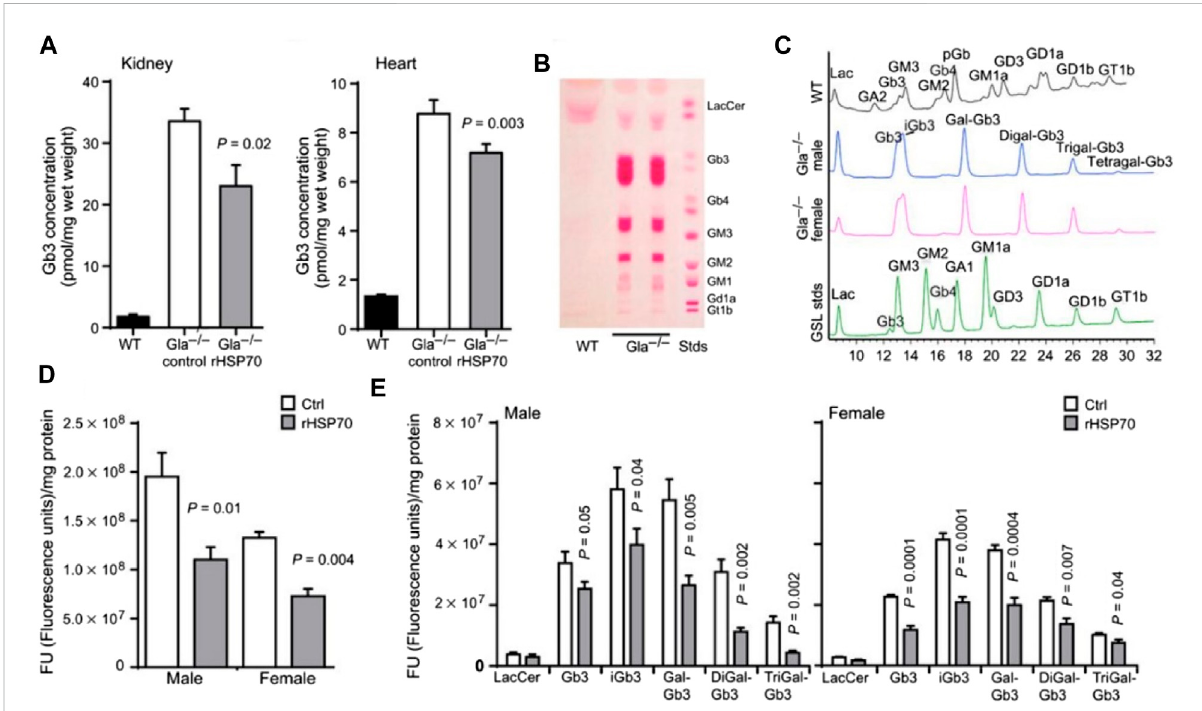
FIGURE 5 (A) Quanti fi cation of Gb3 concentrations in the heart and kidneys after various treatments. (B) Thin-layer chromatographic (B) and high- pressure liquid chromatographic (C) analysis of glycosphingolipid storage in wild-type (WT) and GLA knockout (KO) mice. Quanti fi cation of glycosphingolipid contents in dorsal root ganglia of KO mice with various treatments. Ctrl: control, PBS; rHSP70: rHSP70 intraperitoneal injection, 5 mg · kg − 1 . Reproduced with permission (Kirkegaard et al., 2016). Copyright 2016, American Association for the Advancement of